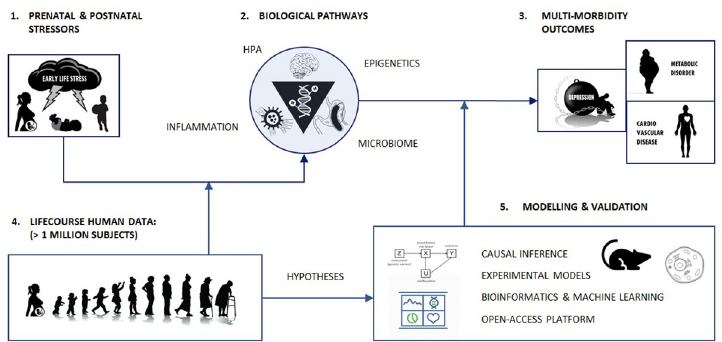
Fig 1. Schematic overview of the EarlyCause project, that will study the link between ELS (1) and multi-morbidity (3), as mediated by biological pathways (2). Large-scale life course human data (4), as well as experimental and computational models, will be used to identify and validate the causative mechanisms.